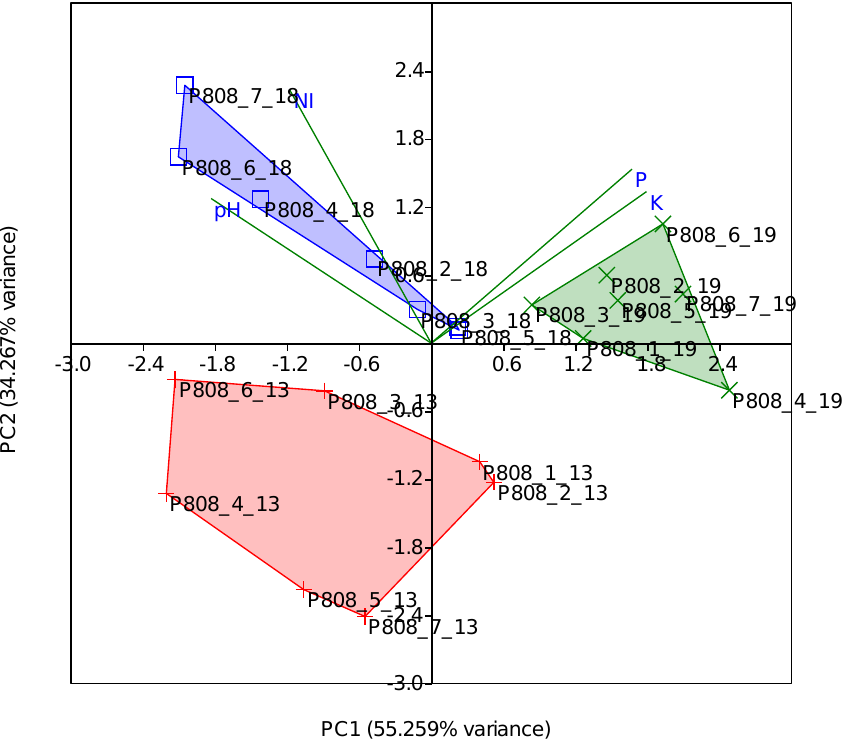
Figure 3. PCA (correlation) diagram, pasture plot P808, Ciacova, Timiș County, Romania, 2013– 2019 period.